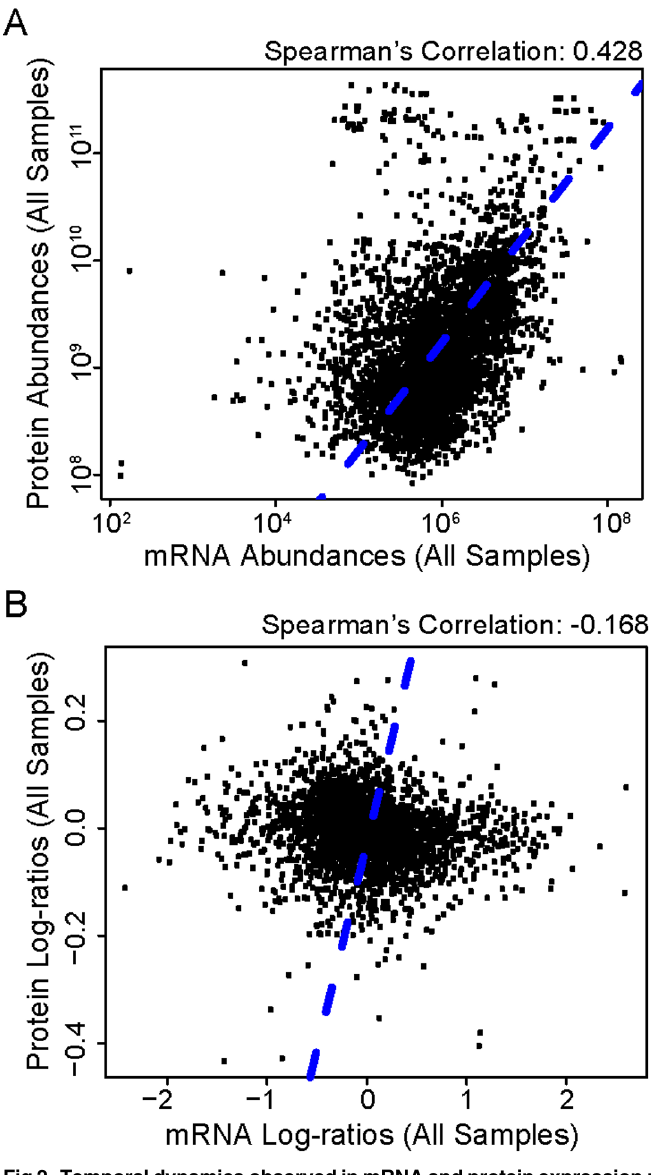
Fig 2. Temporal dynamics observed in mRNA and protein expression using the high-confidence set. (A) Comparison of absolute abundance values for the mRNA and protein expression data (all time points combined) indicates a moderate correlation between the data types (Spearman ’ s correlation coefficient, R S = 0.428, p < 0.0001). (B) Comparison of the log-ratios relative to T3 indicates a slightly negative correlation (R S = -0.168, p < 0.0001). These contrasting results suggest that while a relationship exists between mRNA and protein expression, there are considerable temporal differences between the respective expression